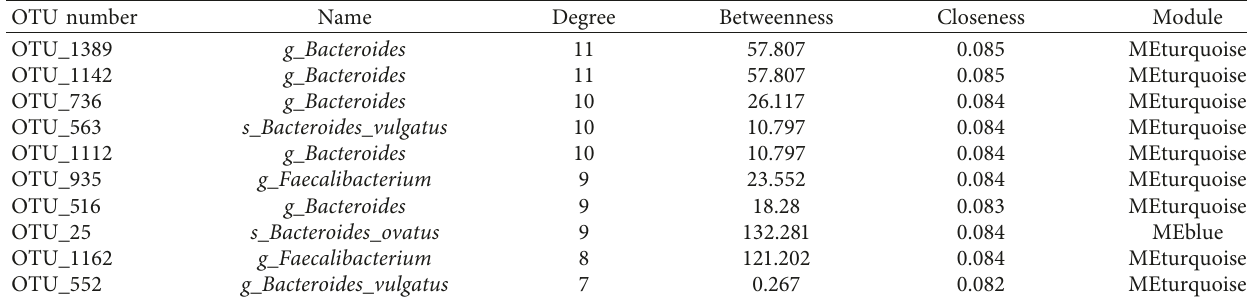
Figure 3: Identified modules by WGCNA. (a) Cluster dendrogram of four identified modules. (b) Adjacency heatmap of eigenOTU which is Table 2: The top ten OTU taxa with outstanding topological